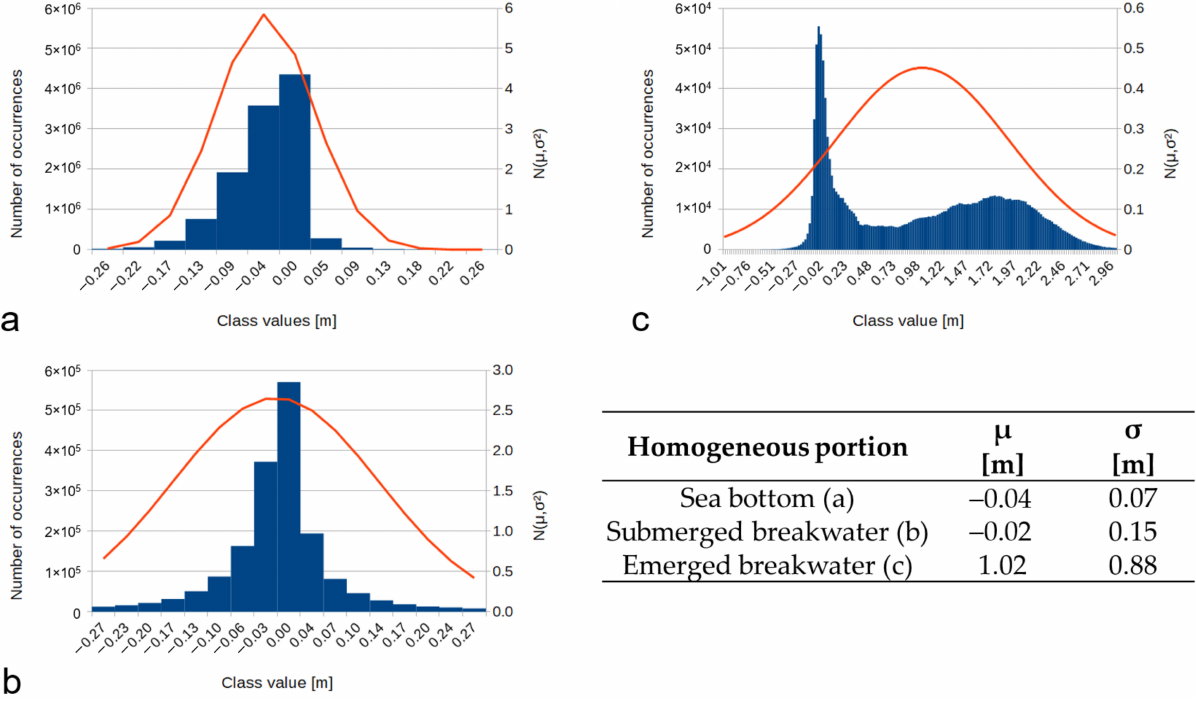
Figure 11. Fitting between a Gaussian function (red line) and the distribution of DSMs differences of sea bottom ( a ), submerged breakwater ( b ), and emerged breakwater ( c ). The distance values are limited within the interval ( − 1; 3) m, corresponding to the µ ± 3 σ confidence